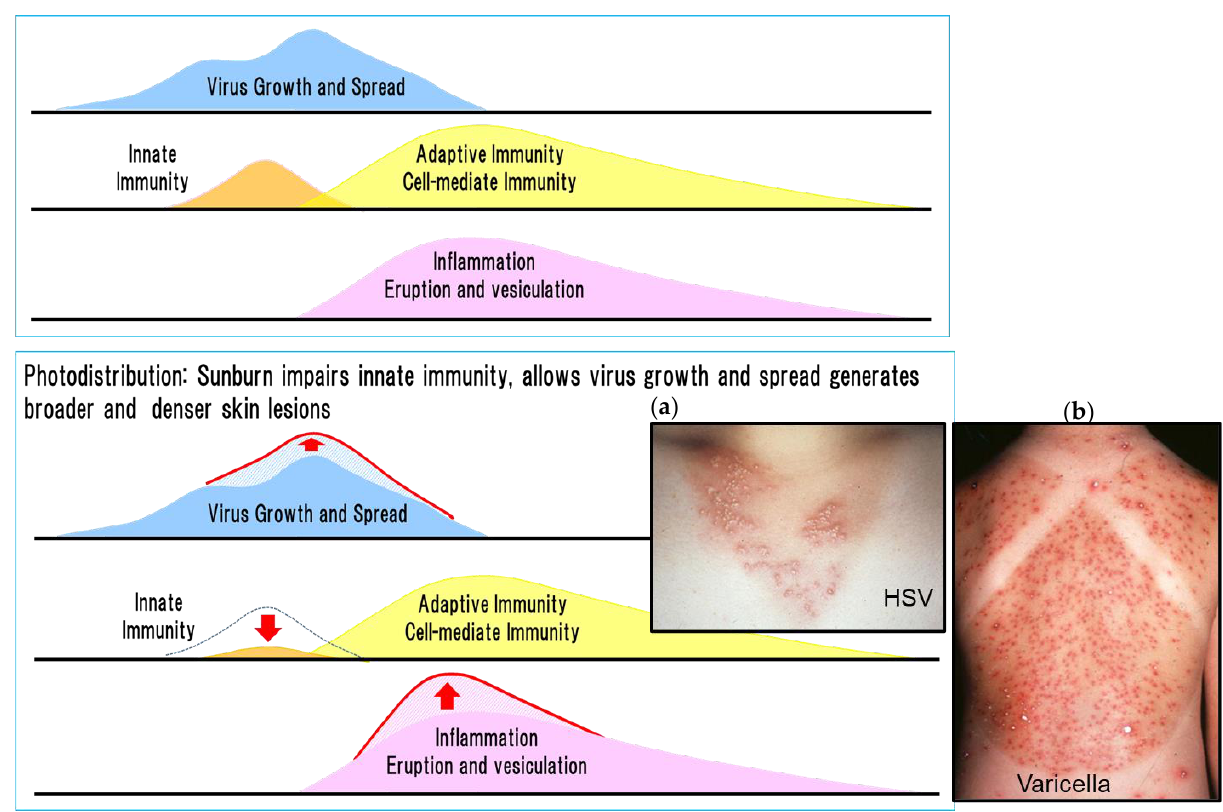
Figure 7. Innate and adaptive immunity and photodistribution [30]. The figure shows the relationship between virus proliferation, innate and adaptive immunity, and rash in HSV and VZV infection. Sunburn modifies virus proliferation, innate and adaptive immunity, and rash as shown by the red arrow in the figure on the right, and causes characteristic photodistribution as shown in the photographs. Exacerbated and dense distribution of skin lesions of HSV and VZV infection related to the inhibition of innate immunity by sunlight exposure (ultraviolet rays). ( a ) A woman in her 20s developed vesicles that were consistently distributed throughout an anterior cervical area exposed to the sun 2 days previously. Denser uniform vesicles and erythema are present in the sun-exposed areas compared with the unexposed areas. The sparse distribution of skin lesions in the area unexposed to sunlight is related to the lack of inhibition of innate immune responses by sun exposure. HSV-1 was present in blister fluid (photodistribution by HSV). ( b ) An 8-year-old girl was diagnosed with varicella with fever and vesicles 3 days after bathing in the sea. Dense uniform vesicles were clustered in the sunburned area, whereas the distribution of eruptions was sparse in the unexposed area where the shoulder straps were located because varicella lesions were inhibited by innate immunity (photodistribution by VZV). In these two cases, innate immunity in the skin was not impaired in areas without sunburn and VZV infection resulted in mild varicella. Thus, innate immunity is important for alleviating dense lesions by inhibiting the growth, spread, and distribution of the virus before inducing adaptive cell-mediated immunity. The photographs were provided by Dr.